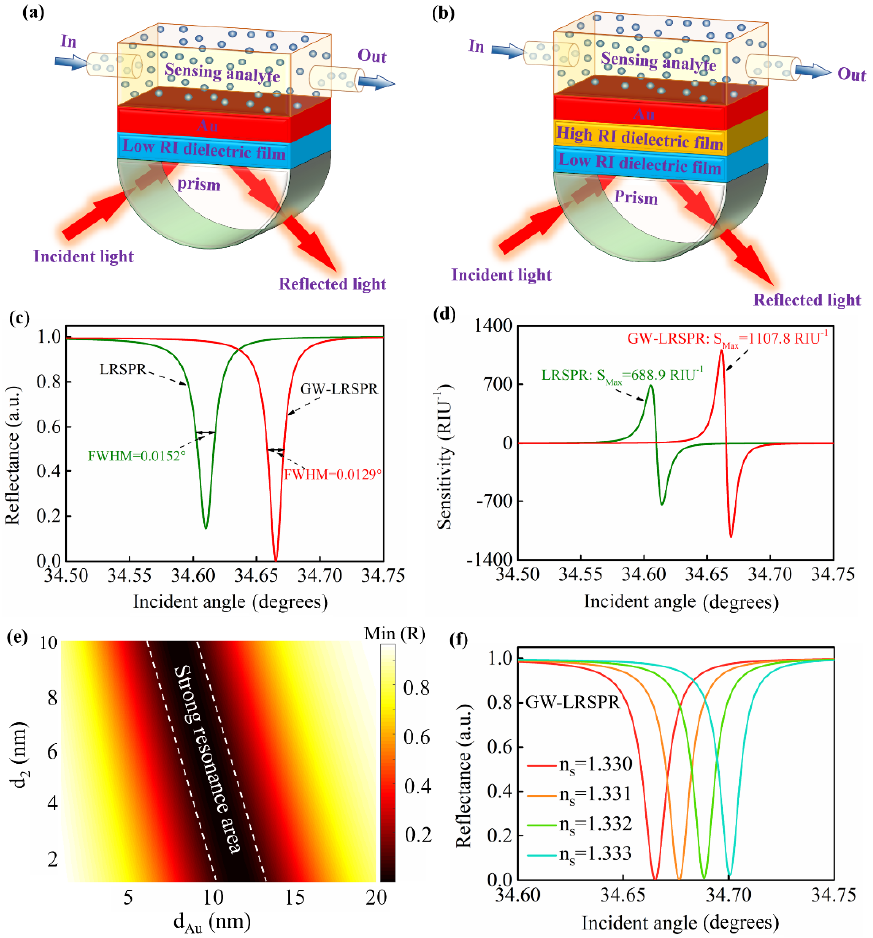
Figure 1. ( a ) Schematic diagram of the 10 nm thick Au − based conventional long − range surface plasmon resonance sensor. ( b ) Schematic diagram of the proposed high − RI − dielectric film − based GW − LRSPR sensor. ( c ) The resonance signals generated from the LRSPR and GW − LRSPR sensors based on the 2S2G prism, where their full width at half maximum ( FWHM s) were 0.0152 ◦ and 0.0129 ◦ , respectively. ( d ) The sensitivities of the conventional Au − based LRSPR sensor and the novel GW − LRSPR sensor. ( e ) The strong resonance area of the proposed GW − LRSPR sensor at different d 2 and d Au values. ( f ) The curves of reflectance excited from the GW − LRSPR sensor when n s ranged from 1.330 to 1.333. Note: the results of Figure c–f were obtained from the LRSPR and GW − LRSPR configurations based on the 2S2G